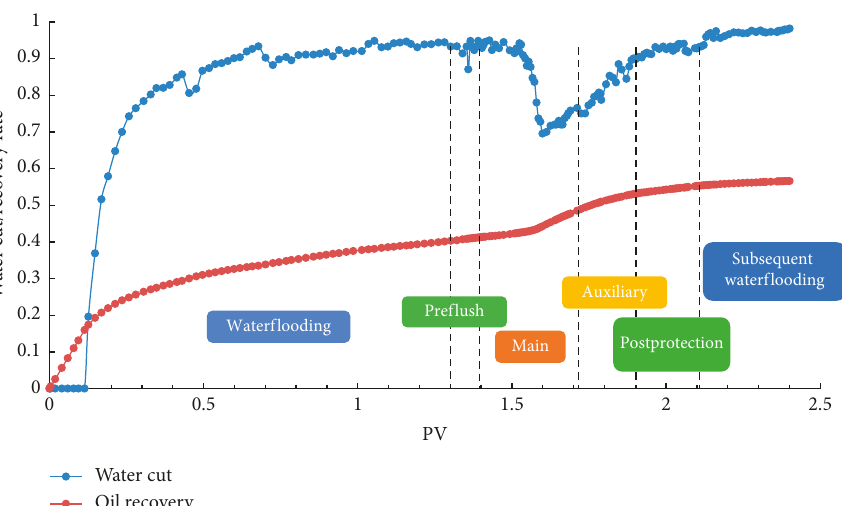
Figure 8: Development performance of No. 1